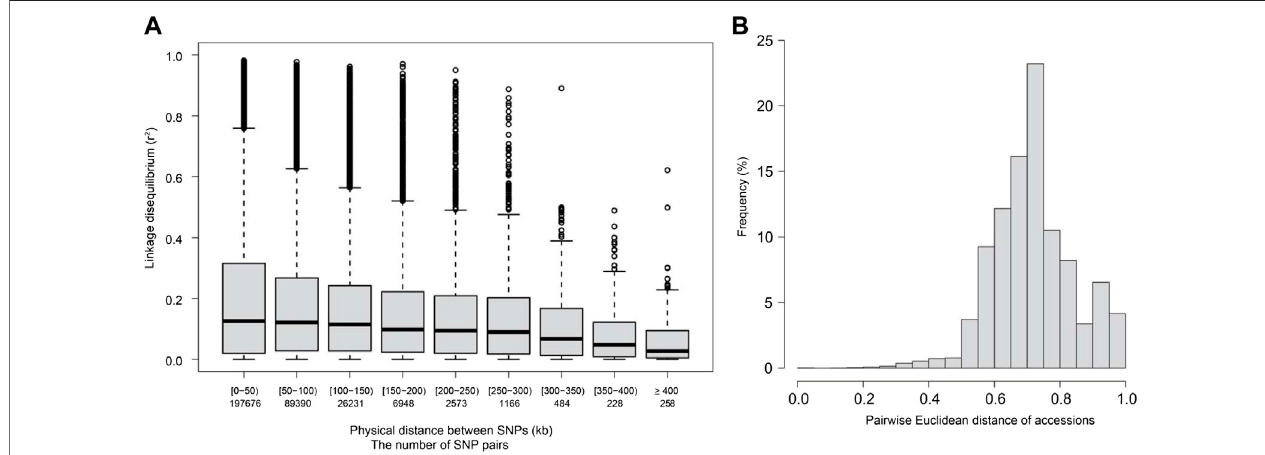
FIGURE 1 | Linkage disequilibrium (LD, r 2 ) decay and Euclidean distance for the 250 diverse rice accessions used in this study. (A) LD decay for the studied accessions. The X -axis represents the physical distance between SNP pairs in kilobases (kb). (B) Pairwise Euclidean distance for the studied accessions.